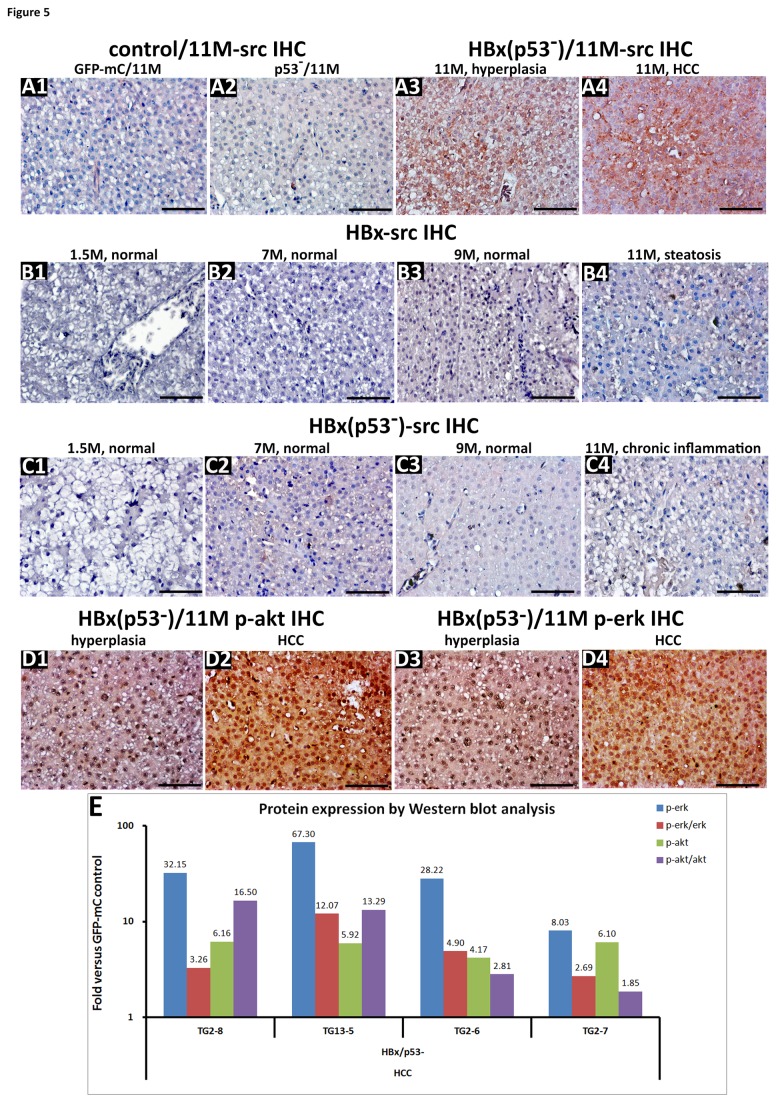
The assessment of src, p-ERK and p-AKT signaling in wild-type, p53 mutant and Tg(l-fabp:HBx-mCherry;cmcl2:GFP) fish with different liver diseases.(A) Immunohistochemical analysis of src protein expression in hepatocytes from the GFP-mC and p53 mutant control fish and HBx(p53-) transgenic fish at 11 months. (B) src IHC results from HBx transgenic fish at 1.5, 7, 9 and 11 months. (C) src IHC results from HBx(p53-) transgenic fish at 1.5, 7, 9 and 11 months. (D) Immunohistochemical detection of phosphorylated ERK and phosphorylated AKT in 11-month-old Tg(l-fabp:HBx-mCherry;cmcl2:GFP) transgenic fish with hyperplasia and HCC (x 400). Scale bars: 50 μm. (E) Western blot analysis for the activation of erk and akt in the livers of transgenic fish at different stages of HCC development. After measuring the band intensity using the UVP VisionWorks LS software, the relative density was normalized to β–actin. The ratios of p-erk/erk and p-akt/akt were analyzed, and the data are expressed as fold changes of HBx(p53-) transgenic fish relative to GFP-mC controls.